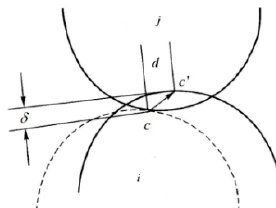
Figure 2. Mutual contact model of two soft spheres.